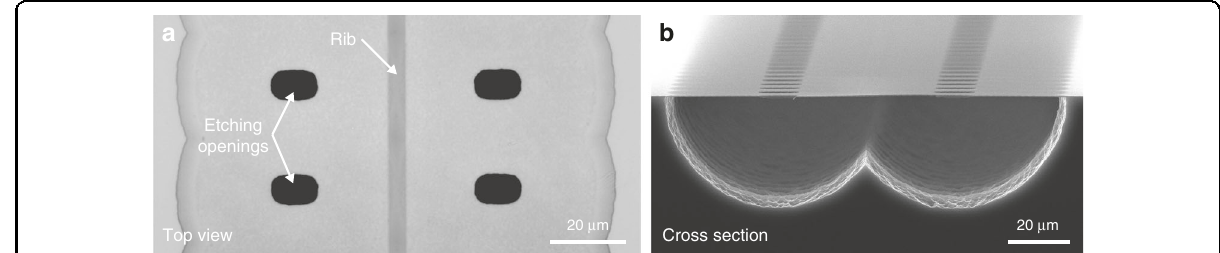
Fig. 2 Suspended rib waveguide. a Top-view optical microscope image of the fabricated waveguide. b SEM image of the waveguide cross section. The fabrication process resulted in a 130 µm wide and 350 nm thick membrane